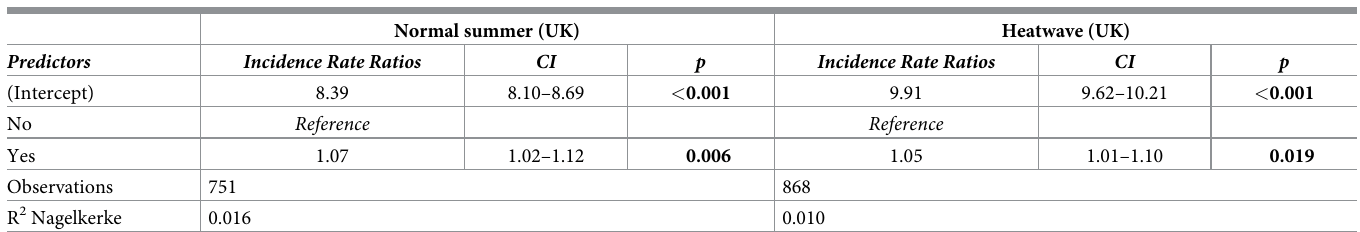
Table 3. Predicting number of overheating actions in the UK.